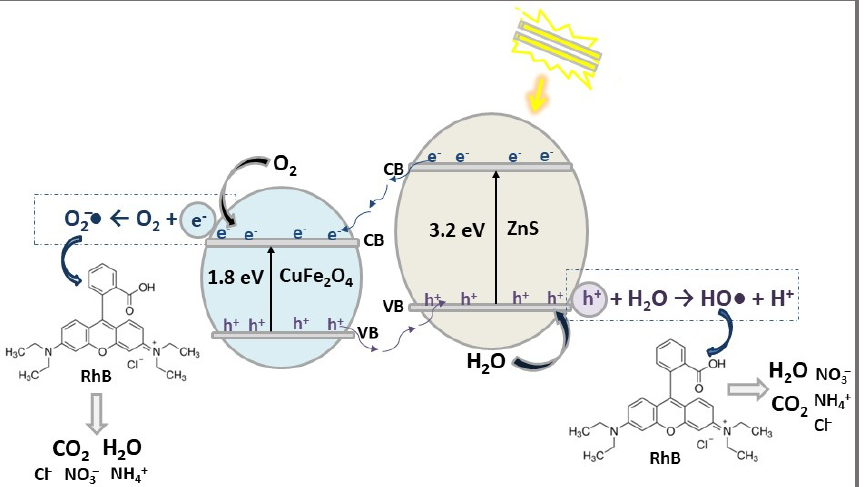
Figure 9. The photocatalytic degradation mechanism of RhB dye using ZnS/CuFe 2 O 4 heterostructure photocatalyst under Vis light irradiation for 2 h.